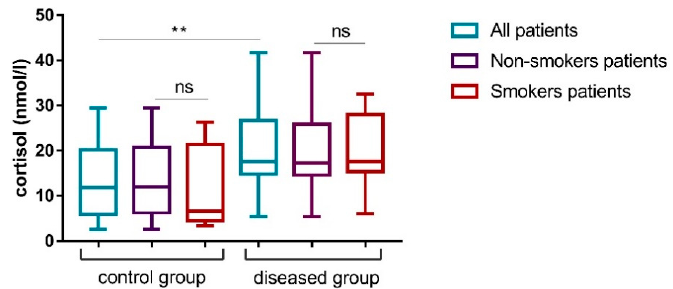
Figure 2. Cortisol concentrations in all patients and according to the smoking status in control and diseased group. ** p < 0.01; ns = non-significant. Clinical factors associated with high salivary cortisol concentrations in pathological sites from diseased patients before SRP were determined using multiple linear regression (Table 3). An association was observed between cortisol and PPD in bivariate ( p = 0.047) and multivariate analysis ( p = 0.04). No significant association was found with the other periodontal parameters. After SRP, no association between periodontal parameters and psychosocial factors, both anxious and stress auto-questionnaires was found. (Table 4). However, when the extreme categories were compared, diseased patients, with high anxiety (according to the self-assessment of anxiety – STAIYA) seem to have a risk 5.33 times higher of having an enhancement of their supragingival biofilm than non-anxious one (0.89–31.92, p = 0.07) (result not shown). 3.3. Stress/Anxiety and Periodontal Bacteria No linear relationship of salivary cortisol concentrations with the presence of specific periodontopathogens or with total amount of microbiota was found before SRP (Table 3). However, there may be a statistical trend of a linear association between the presence of P. micra and low levels of salivary cortisol in bivariate and multivariate analyses ( p = 0.06). In addition, no correlation between salivary cortisol concentrations and the total amount of microbiota was identified (Supplementary Figure S2, p > 0.05). The presence of periodontopathogens according to anxiety and stress levels before treatment was described in Table 5. In the diseased group, T. forsythia was significantly recovered in periodontal pockets samples of all highly stressed patients in comparison with non-highly stressed patients ( p = 0.03), and A. actinomycetemcomitans was exclusively detected in pockets of non-anxious patients ( p = 0.08). None of the other identified bacteria demonstrated a difference in their detection in relation to the stress or anxiety parameters. Regarding the relationship between the evolution before and after SRP of the presence of some periodontopathogens bacteria according to psychosocial indicators, some significant associations were observed (Table 6). The evolution of P. gingivalis varied significantly according to STAI-YA categories ( p = 0.03) with higher persistence and appearance in anxious and non-anxious patients by comparison with very-anxious patients from diseased group. No difference in the evolution of any periodontopathogens has been observed with STAI-YB categories (Supplementary Table S4). According to the PSS scale, in diseased group, significant differences in the evolution of detection of T. forsythia , F. nucleatum and C. rectus were observed after SRP. T. forsythia and C. rectus were more detected in very stressed patients than non-stressed or managed stress patient ( p = 0.02, p = 0.009 respectively). Regarding F. nucleatum detection, this species was more persistent in managed stress and stressed patients than non-stressed patients. However, none of these results remained significant after grouping anxiety and stress categories: anxious and very anxious patients for STAI-YA and non- stressed and stress-managed patients for PSS ( p > 0.05).